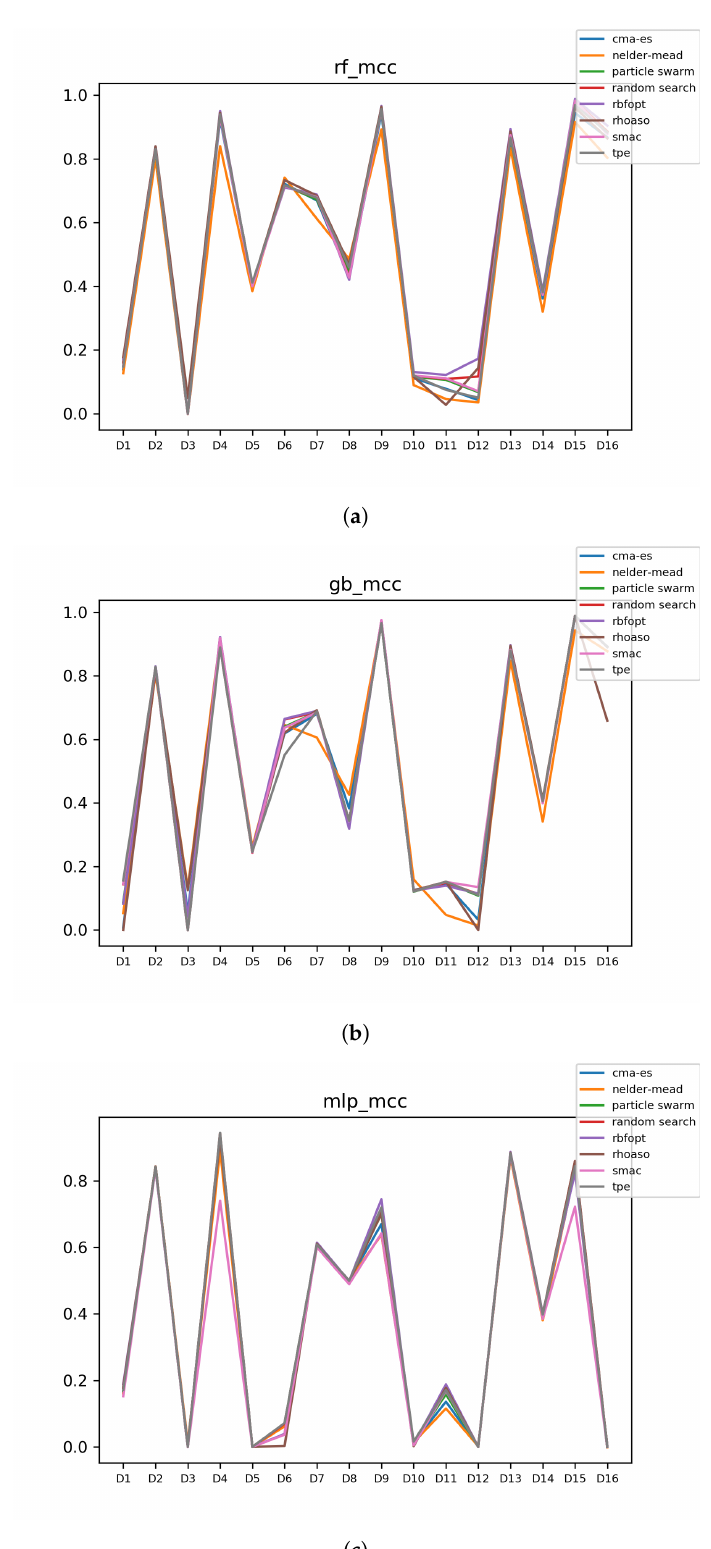
Figure 15. Experiment 2: MCC of all HPO algorithms. ( a ) MCC in RF. In axis X, the dataset. In axis Y, the MCC obtained. Each line represents a HPO algorithm. ( b ) MCC in GB. In axis X, the dataset. In axis Y, the MCC obtained. Each line represents a HPO algorithm. ( c ) MCC in MLP. In axis X, the dataset. In axis Y, the MCC obtained. Each line represents a HPO